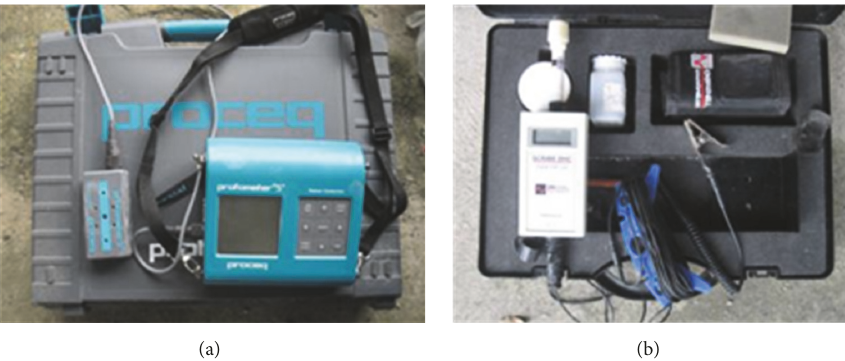
Figure 4: (a) Rebar locator (profometer 5 + ) and (b) SCRIBE DHC digital half-cell meter.